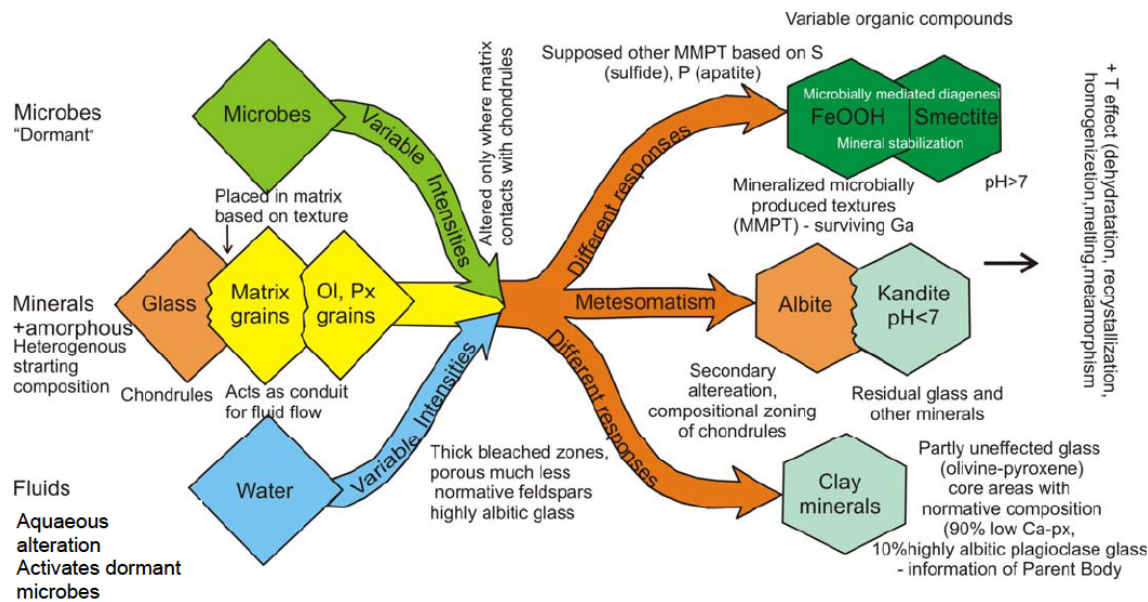
Figure 6. Summary of the mineral transformations if three threads of actors are individually considered in the complex system of the UOC alteration processes: water (fluids), initial minerals and microbes. Heterogenity at all stages, variable mass ratio conditions and intensity of processes on parent body abiogenic and microbial processes are together in variable ratios. Legend: Ol - olivine; Px -